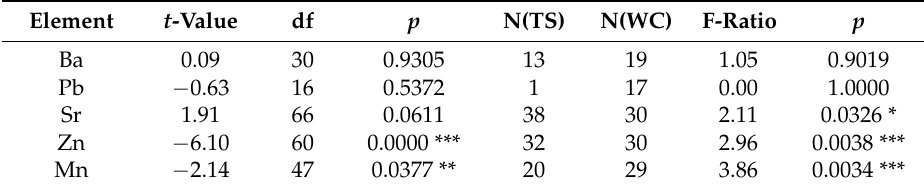
Table 4. Comparison of the concentrations of selected five element measurements between bone samples from the Tian-Shan mountains and the Tatra mountains by the Student’s t -test. Element t -Value df p N(TS) N(WC)